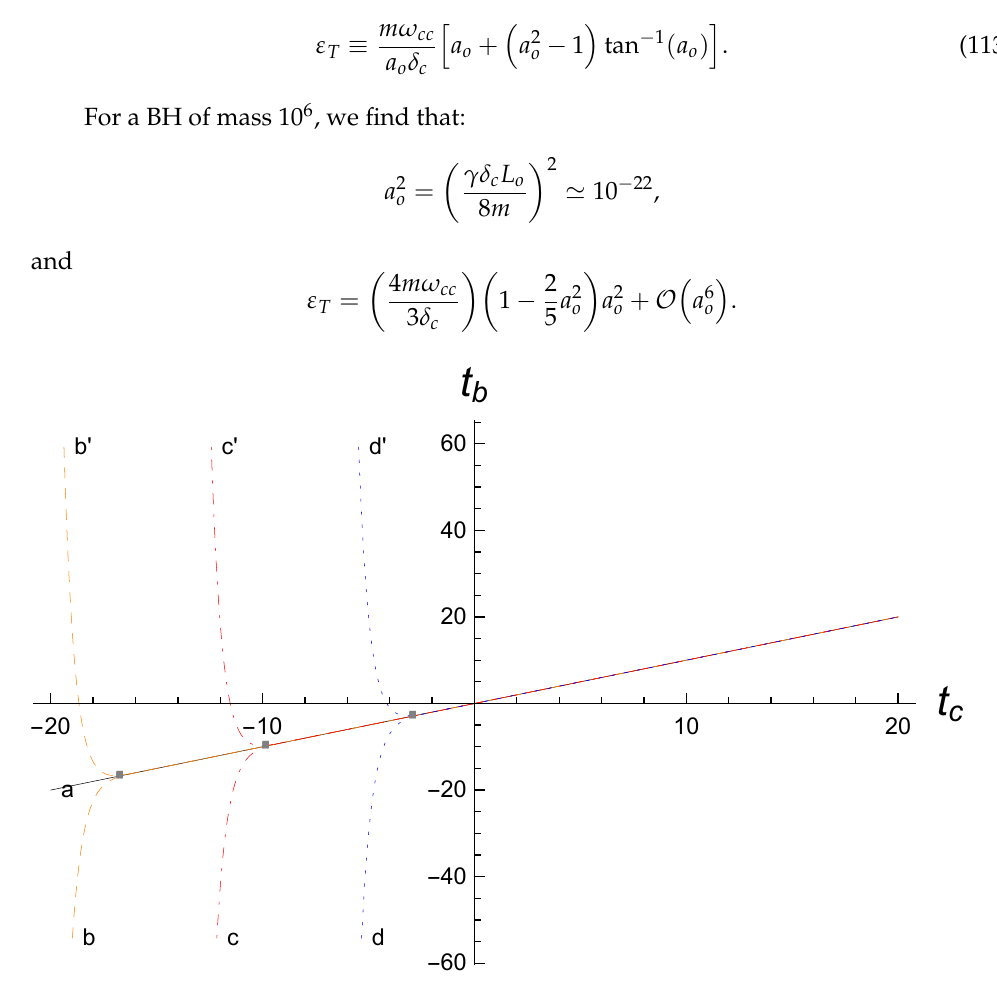
Figure 3. Plots of t b vs t c for α 1 = 0 defined by Equation (104). Depending on the signs of Ω c , the dependence of t b on t c is different. Curves b , c and d are all for Ω c = 0.5 but with different choices of ( m , δ c ) . In particular, they correspond to ( m , δ c ) = { ( 10 6 ,10 − 7 ) , ( 10 6 ,0.1 ) , ( 1,0.1 ) } , respectively. Curves b (cid:48) , c (cid:48) and d (cid:48) are all for Ω c = − 0.5 but with the same choice of ( m , δ c ) as that of the unprimed curves in the respective